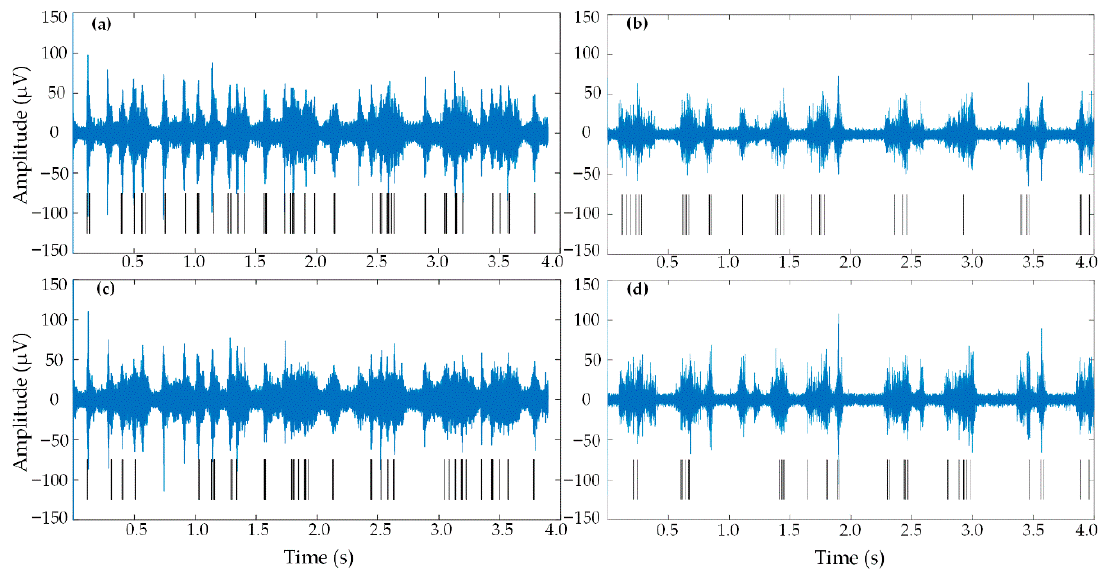
Figure 13. Continuous data from the rapidly multiplexed CMOS test chip (left column) and the Cerebus system (right column). All data were filtered from 800 Hz to 4 kHz using a digital bandpass filter implemented in MATLAB. Black lines under each plot indicate threshold crossing events. The top row contains data from the same electrode recorded from the test chip ( a ) and Cerebus ( b ). The second row contains data from a second electrode recorded from the test chip ( c ) and Cerebus ( d ).